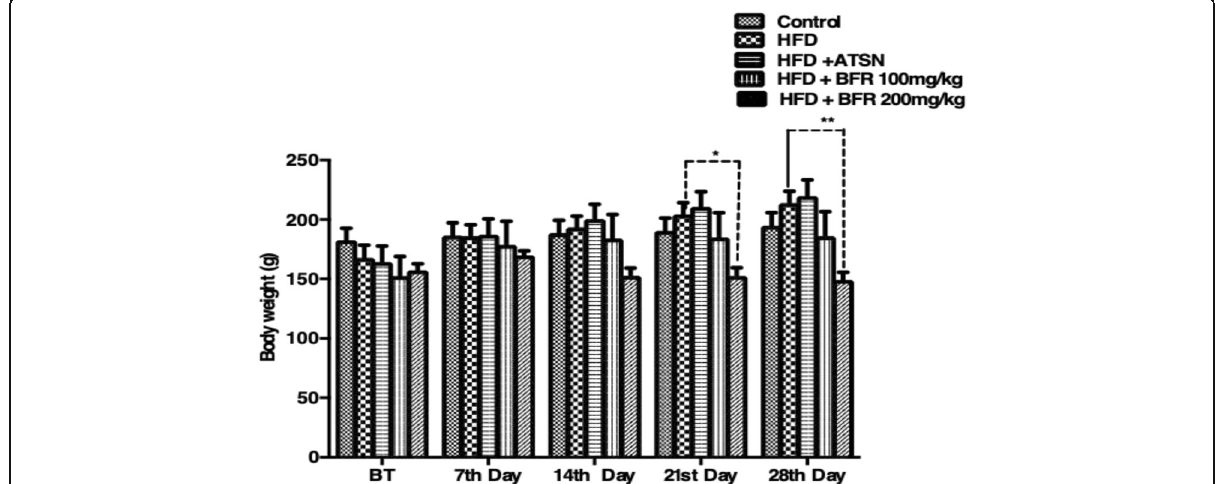
Fig. 2 Effect of BFR and ATSN in body weight of high-fat diet-fed rats. Data were expressed as mean ± SD. Comparison made between HFD vs control and HFD + ATSN vs HFD group, HFD + BFR vs HFD. Statistical significance at * p < 0.05 and ** p <